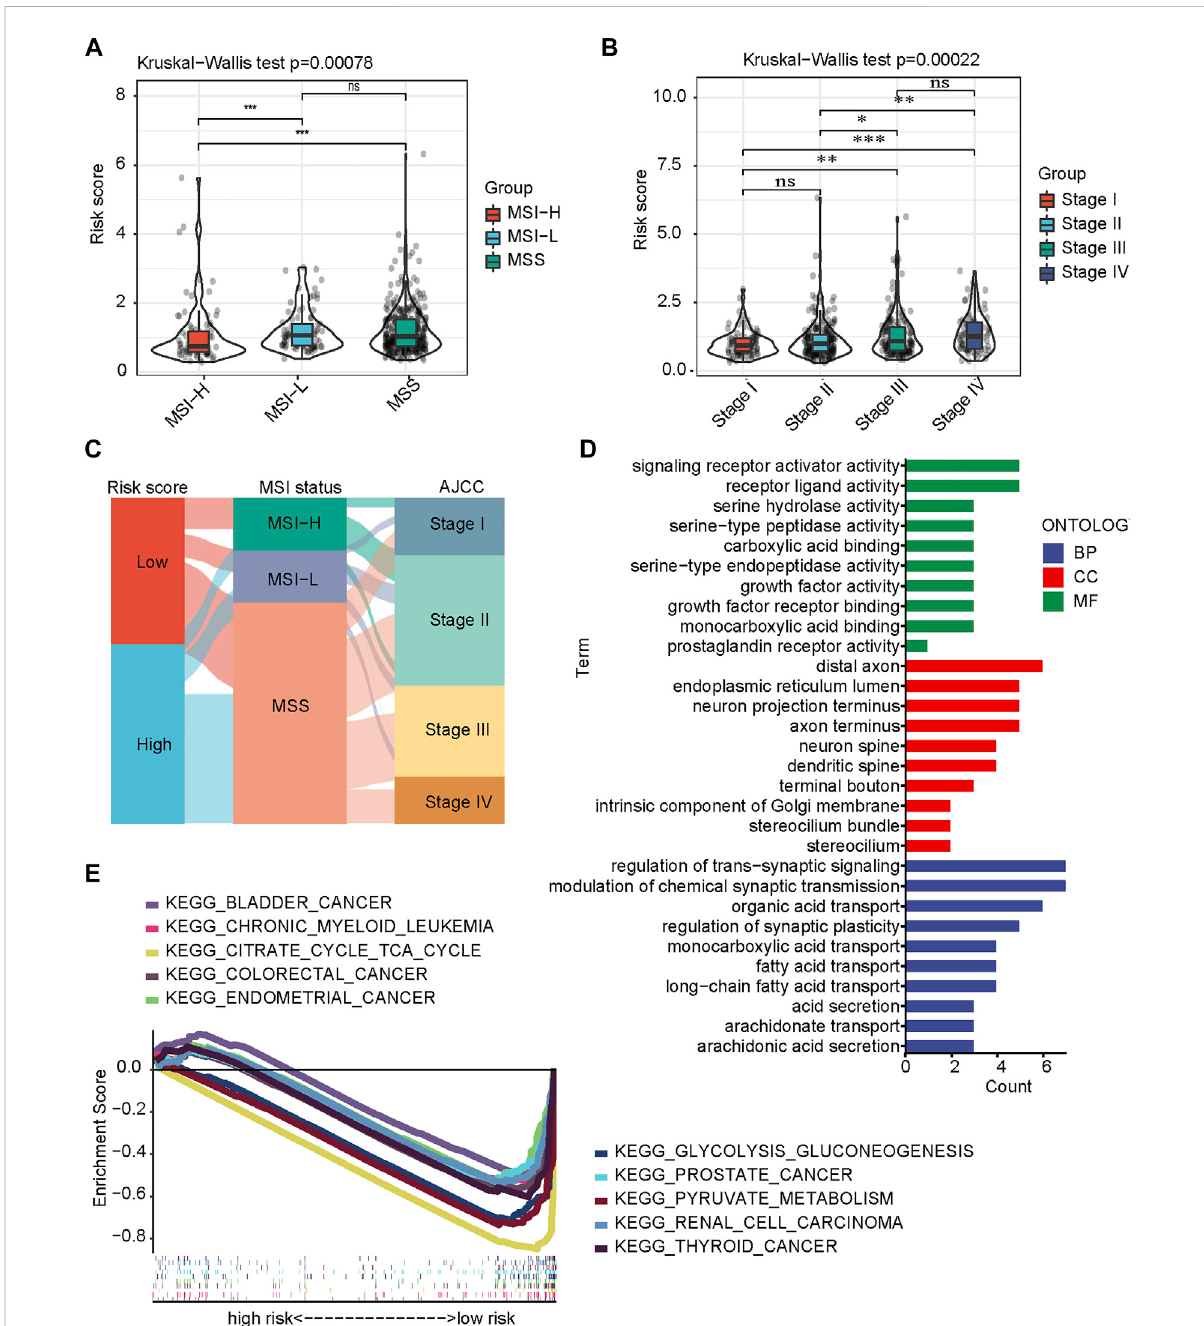
FIGURE 3 Clinicopathological features and biological functions between CRG-Score groups. (A) Differences in CRG-Score among CRC molecular subtypes (Kruskal – Wallis test). (B) Differences inCRG-Score inclinicalstaging ofCRC (Kruskal – Wallis test). (C) Association of CRG-Score, molecular subtypes and clinical stage in CRC. (D) GO analysis. (E) KEGG analysis on